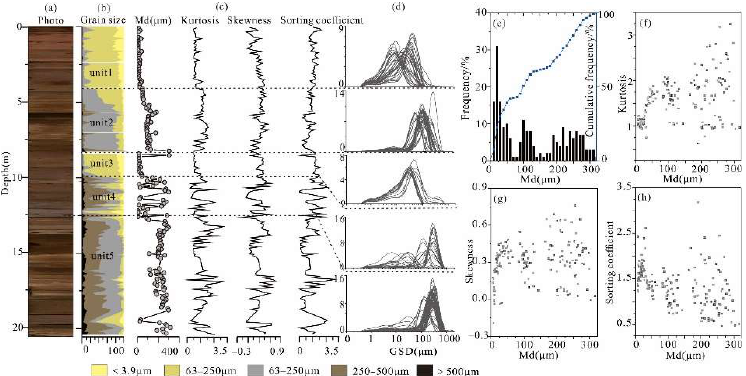
Figure 3. ( a ) High-resolution photos of core HDZ04 were taken by the XRF in situ scanner. ( b ) Grain-size composition of core sediments. ( c ) Grain-size parameters of core sediments in HDZ04. ( d ) Grain-size distributions of sediments in the different units. ( e ) Frequency distribution histogram and cumulative frequency of median diameter in HDZ04. ( d ) Plots of median diameter and kurtosis ( f ), sorting coefficient and median diameter ( g ), median diameter and skewness ( h ) in core